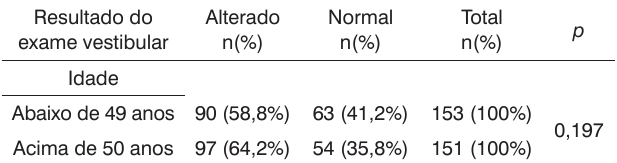
Tabela 3. Associação entre resultado do exame vestibular e idade da amostra (Teste